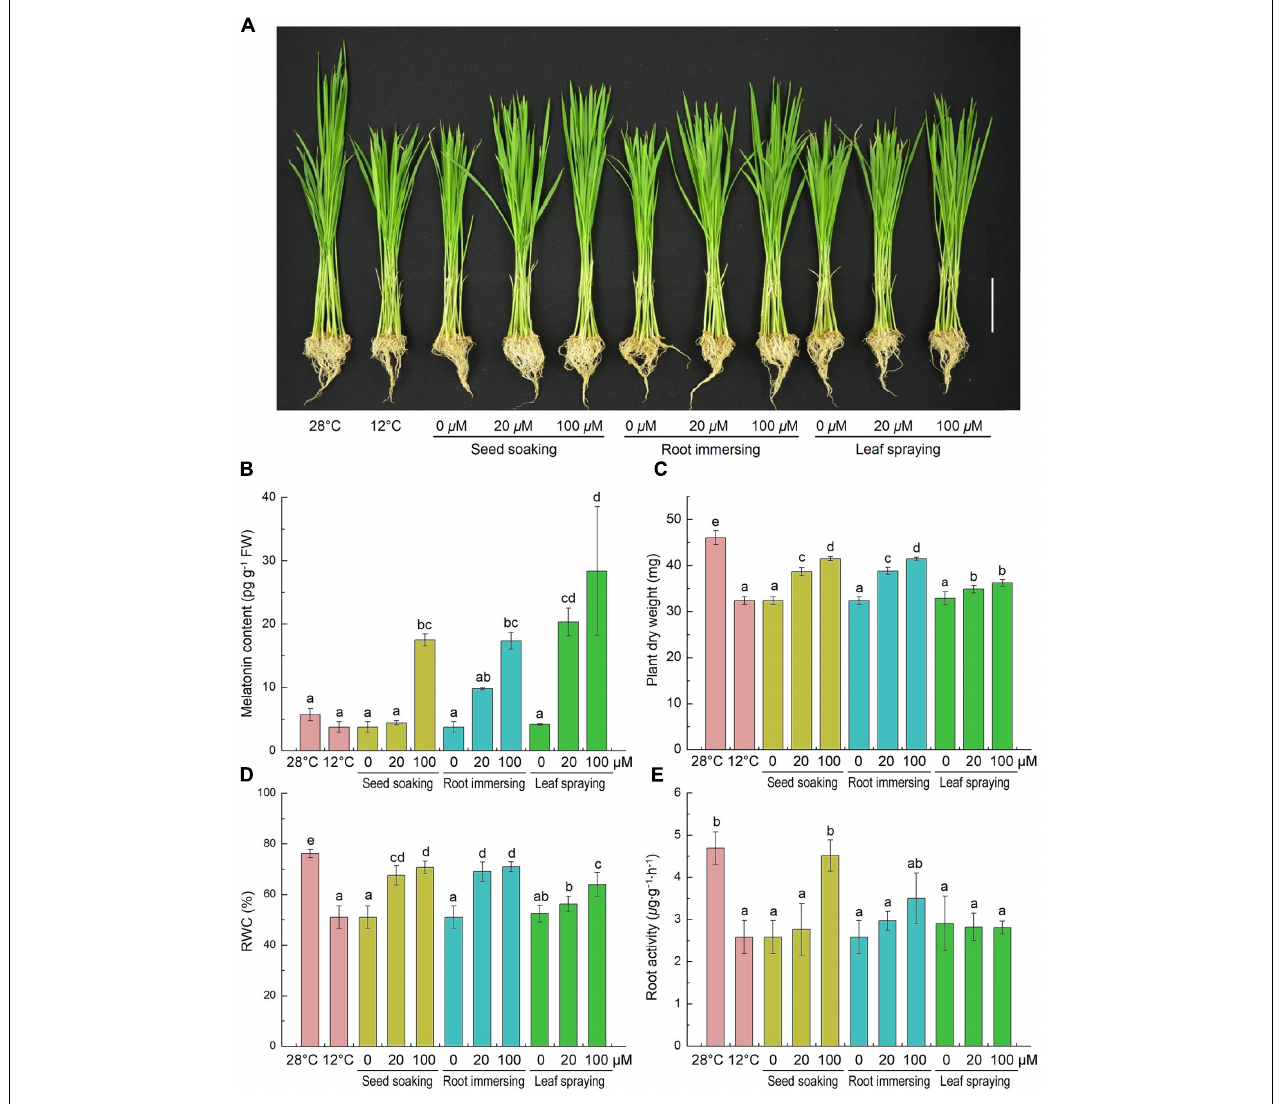
FIGURE 1 | Effects of exogenous melatonin on growth (A) , melatonin content (B) , plant dry weight (C) , leaf relative water content (D) and root activity (E) after 6-day cold stress (12 ◦ C). (A) Bar = 5 cm. (B–E) Data represent means ± SDs of three replicate samples. Bars with different letters indicate significant differences according to Duncan’s multiple range test at P < 0.05. I – seed soaking, II – root immersion, III – leaf